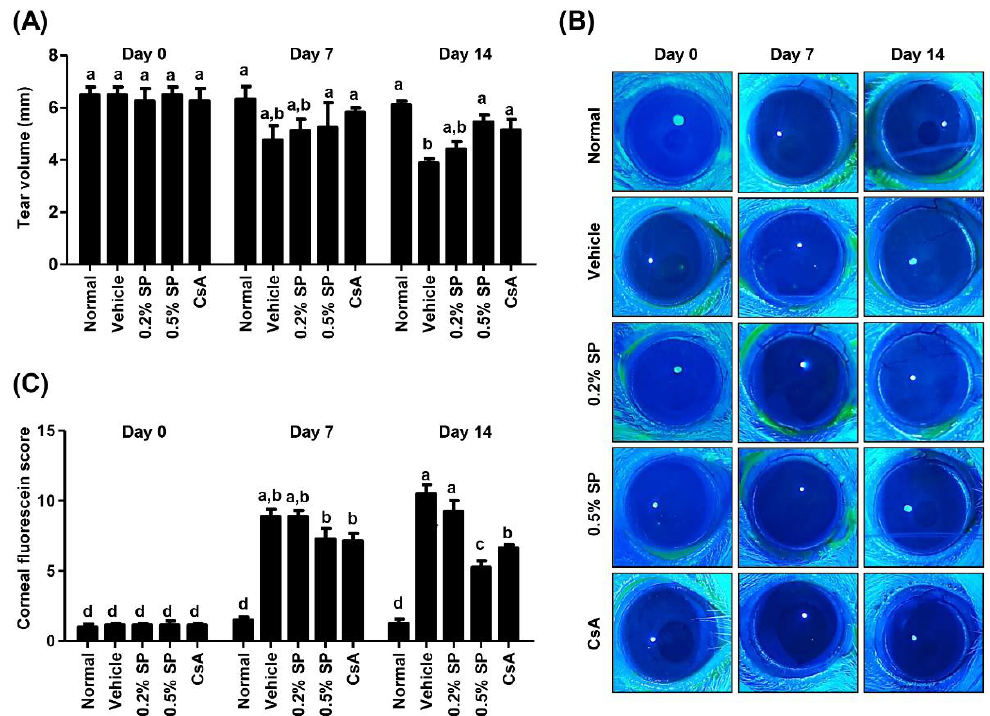
Figure 1. Effect of spermidine on tear secretion and corneal fluorescein staining (CFS) after topical exposure to PM 2.5 in SD rats. ( A ) Changes in tear volume. The volume of tears secreted is measured using the phenol red thread test. The length of the thread that changed color to red is shown for each group at days 0, 7 and 14. ( B ) Representative images of CFS. ( C ) Changes in CFS score at days 0, 7 and 14. The data are expressed as the means ± standard deviation ( n = 5). a Bars are significantly different at p < 0.05 from Bars with b , c , and d . b Bars are significantly different at p < 0.05 from Bars with a , c , and d . c Bars are significantly different at p < 0.05 from Bars with a , b , and d . d Bars are significantly different at p < 0.05 from Bars with a , b , and c